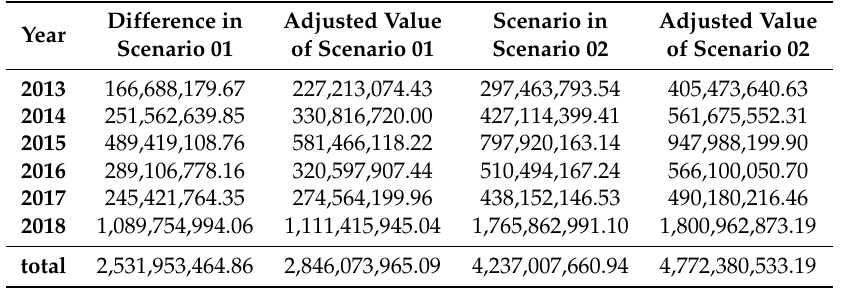
Table 6. Values adjusted by National Consumer Price Index (IPCA) for the two test